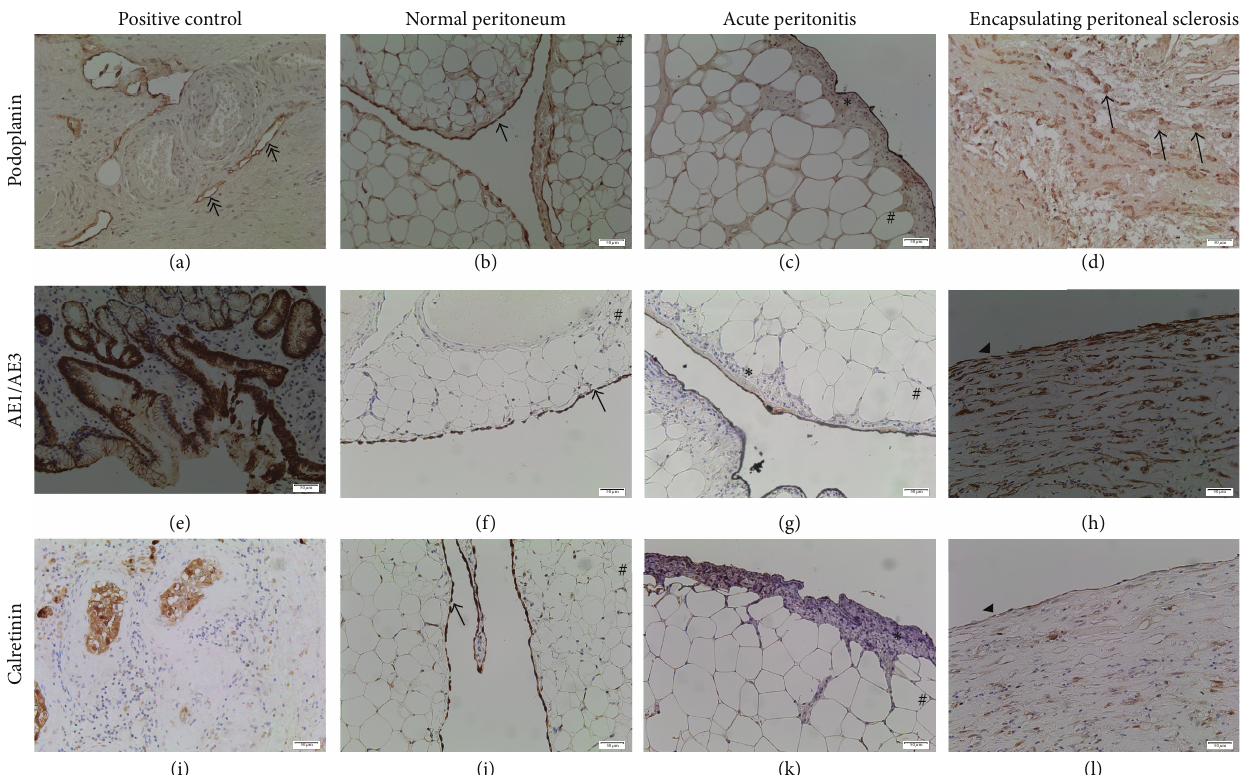
Figure 3: Peritoneal biopsy representative photomicrographs of mesothelial phenotype markers expression: podoplanin (a–d), cytokeratin AE1/AE3 (e–h), and calretinin (i–l). Positive control of immunostainings for used antibodies (internal controls) (a, e, and i), control case: normal peritoneum (b, f, and j), case of acute peritonitis (control 3, c, g, and k), and case 1 of encapsulating peritoneal sclerosis (EPS) (d, h, and l). Physiologic expression of podoplanin (cytoplasm of endothelium in lymphatics ( 󴀀󴀤 )), AE1/AE3 cytoplasm in epithelial cells of stomach